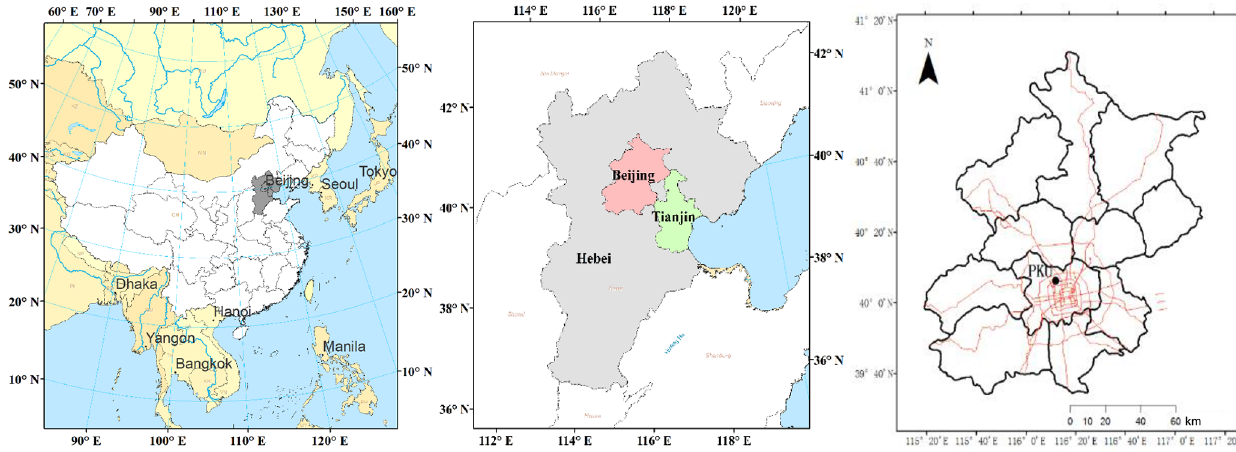
Figure 1. The location of the BTH region in China (shaded area) and the sampling site (black dot).